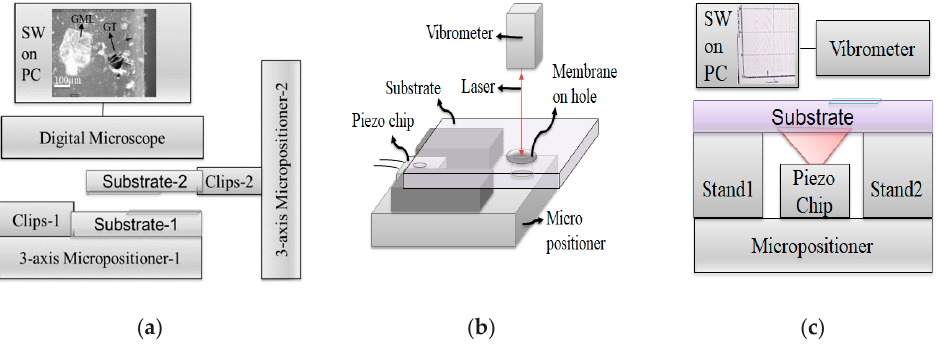
Figure 1. ( a ) Block diagram of the membrane transfer set-up with a microscope image of graphite (GT) and graphene many layer (GML) on glass; ( b ) deflection measurement system set-up and ( c ) deflection measurement system block diagram.